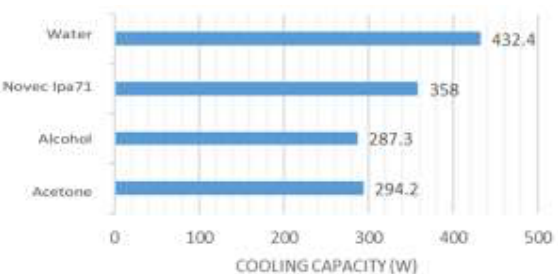
Fig. 11. Comparison of cooling capacity, load 500 W, volume 100 %.